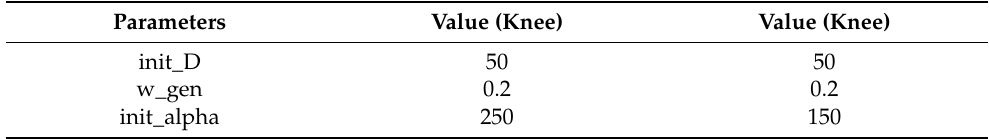
Table 1. Model parameters of LWPR set in the